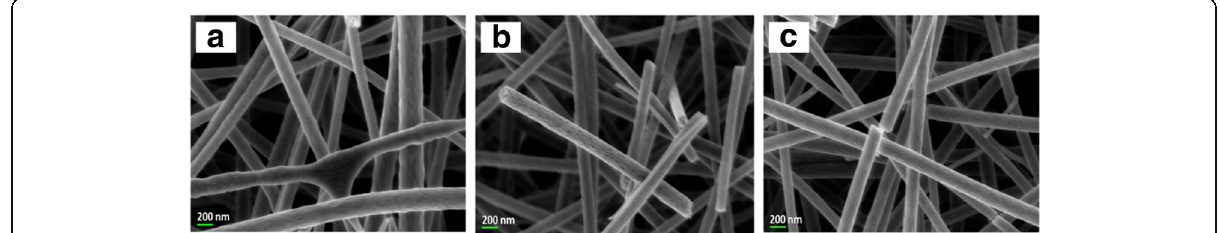
Fig. 8 FESEM image of a TiO 2 -CNF (D14), b TiO 2 -CNF (D16), and c TiO 2 -CNF (D18) at ×30,000